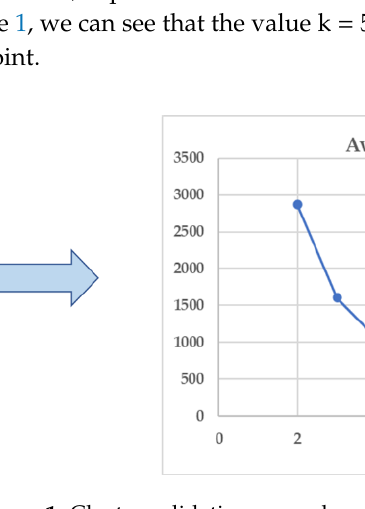
Figure 1. Cluster validation example.